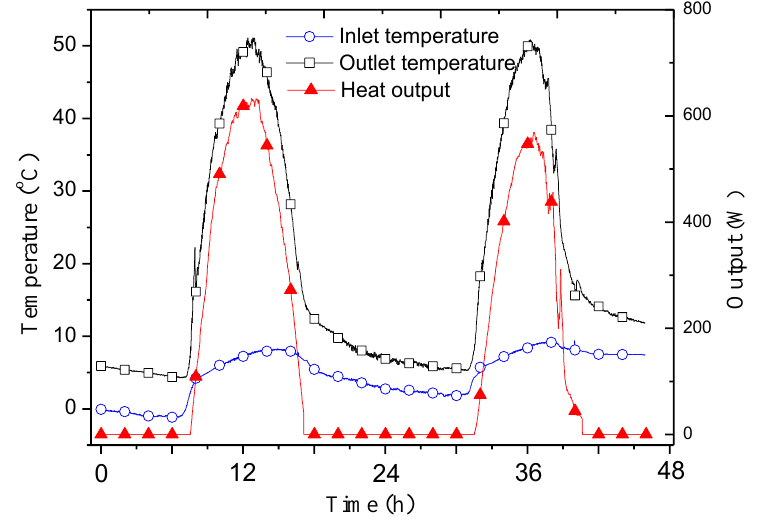
Figure 11. The outlet temperature and heat output of DFSC.